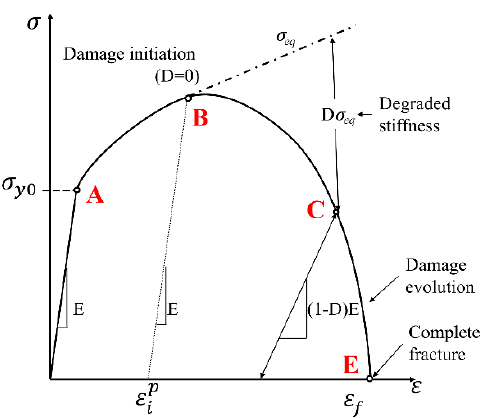
Figure 1. Schematic representation of damage evolution in the software on a typical stress–strain curve